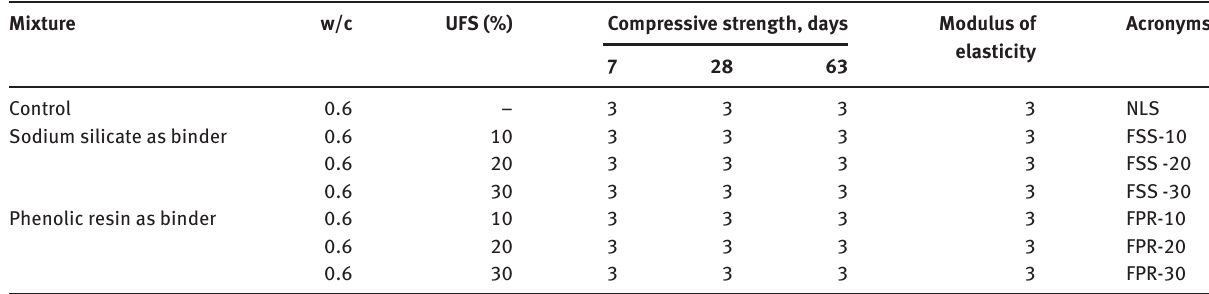
Table 3: Summary of specimens and tests performed on hard concrete.